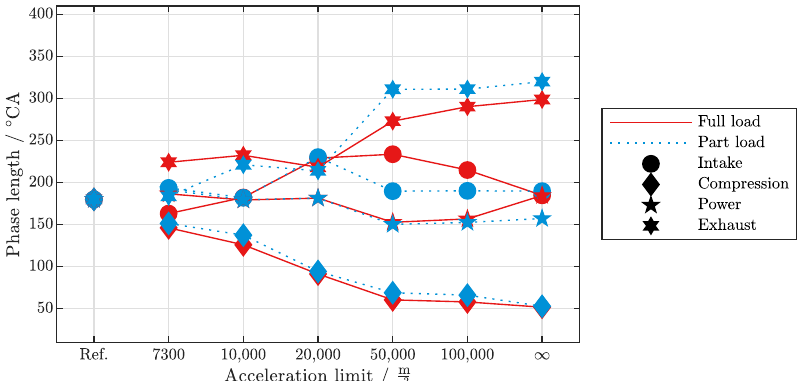
Figure 7. Evolution of the phase lengths for full and part load operation as a function of a maximum piston acceleration limit.